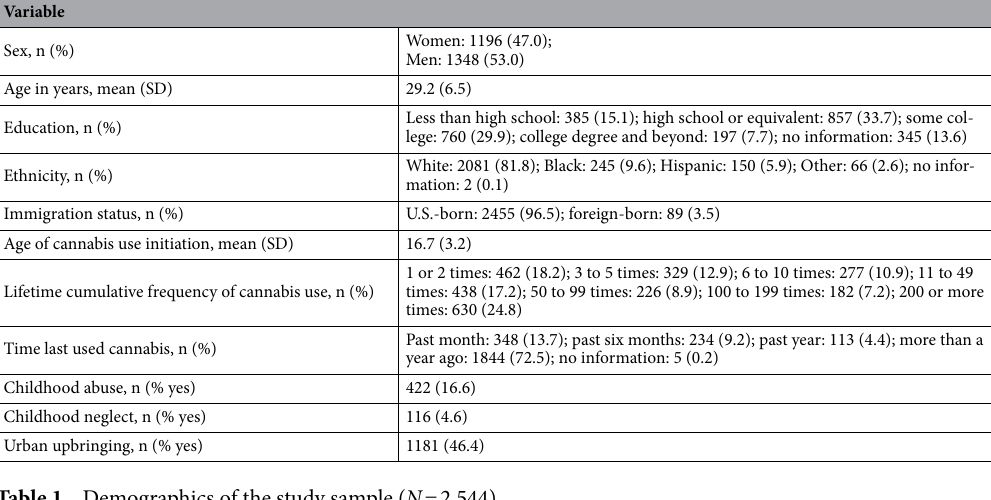
Table 1. Demographics of the study sample ( N =